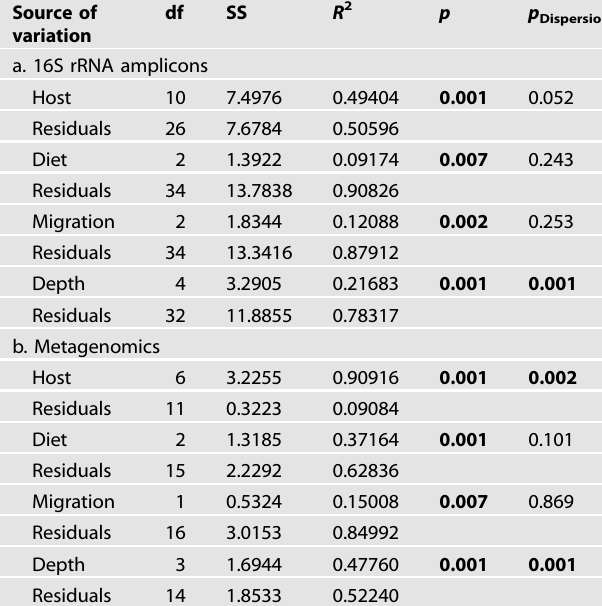
Table 3. Results for PERMANOVAs applied to Bray – Curtis transformed microbiome data based on a 16S rRNA amplicons and b shotgun